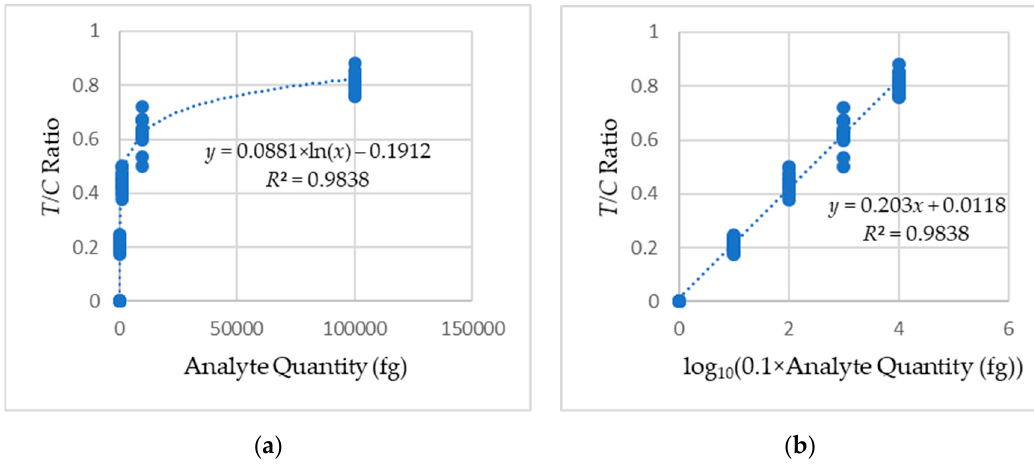
Figure 15. Calibration curves obtained from the regression analysis of the LFA sets: ( a ) logarithmic and ( b ) linear. Table 4. Mean, std. deviation and coefficient of variation of test to control line signal intensity ( T/C ) ratios for each of the analyte quantities of the LFA sets.